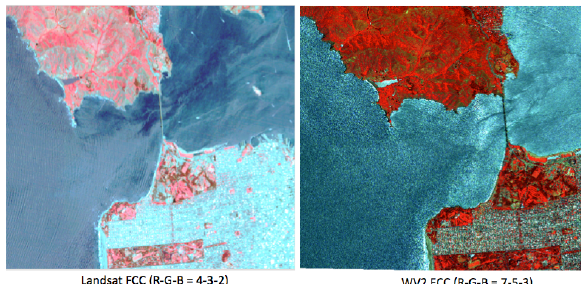
Figure 6. FCC of San Francisco area in Landsat and WV-2 resolution.